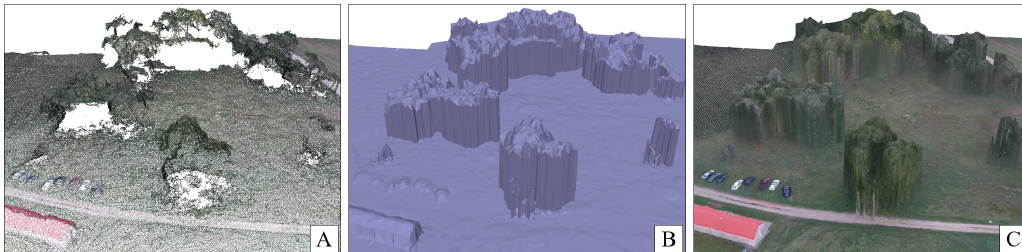
Figure 7. Processed RGB imagery using Structure from Motion (SfM) techniques. Visible lack of data below the canopy on dense point cloud ( A ) and resulting misrepresentation of the canopy structure on a 3D model ( B ) and textured 3D model ( C ). Table 4. Main parameters of some commonly used multispectral cameras, after Deng et al. [26],